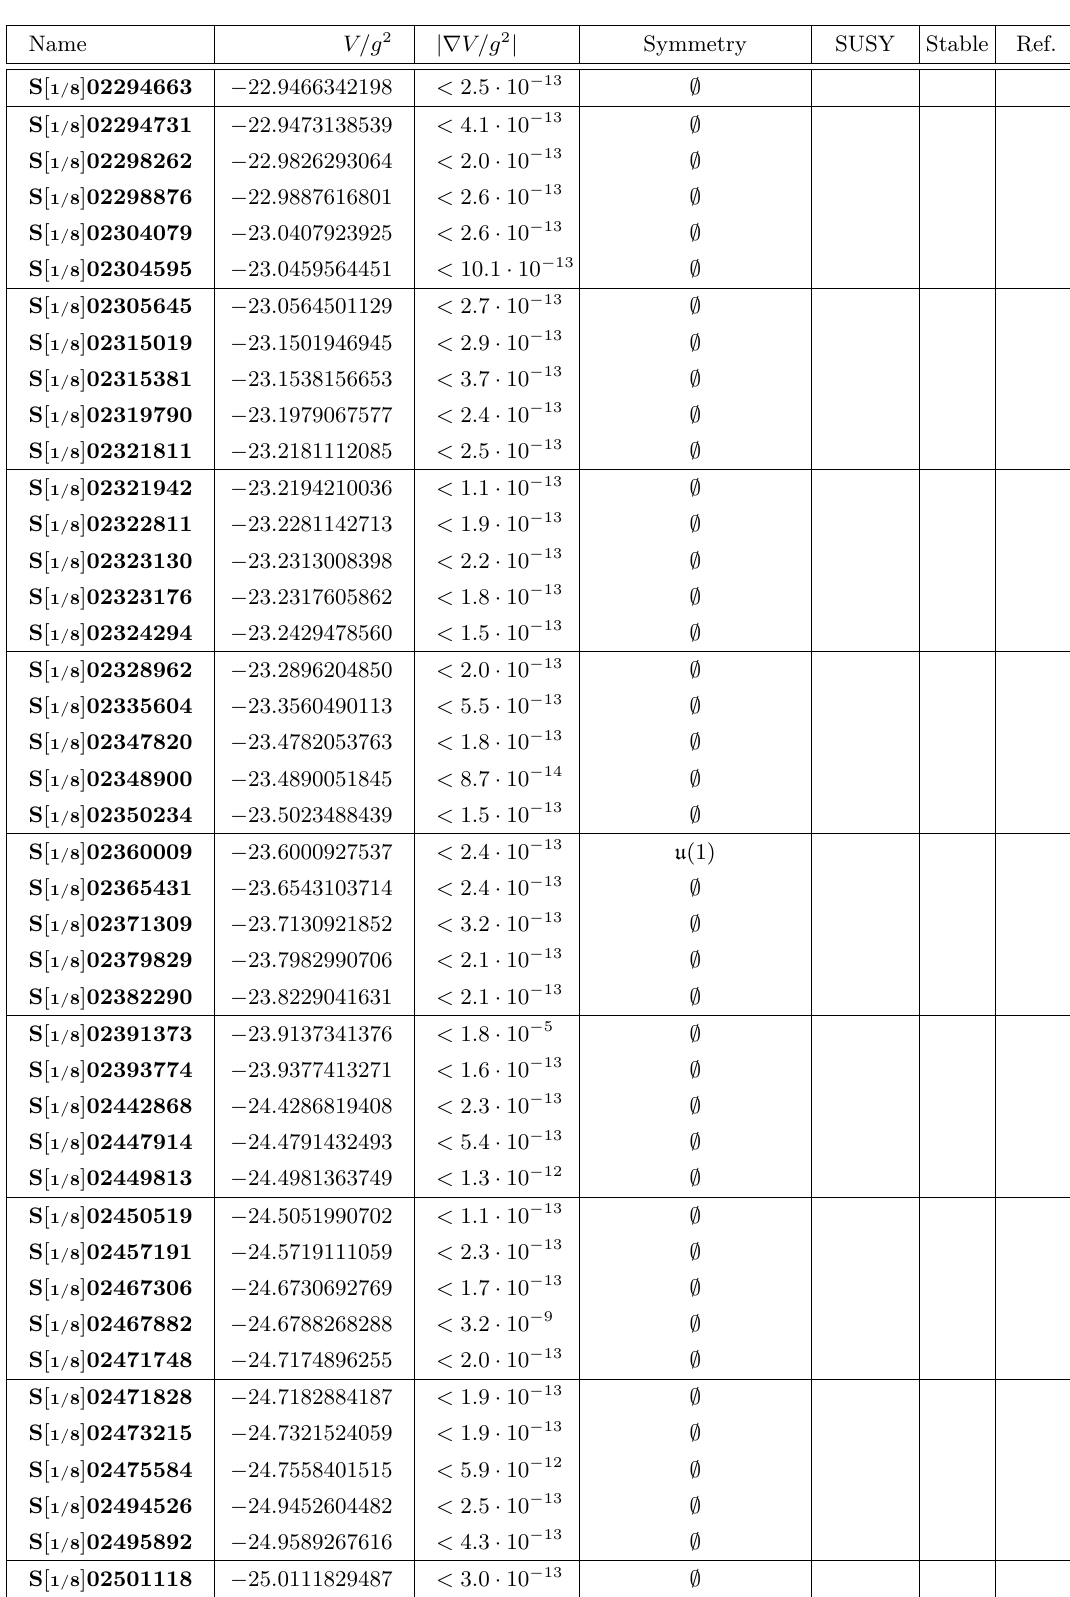
Table 1. Summary of vacua at ω = π/ 8